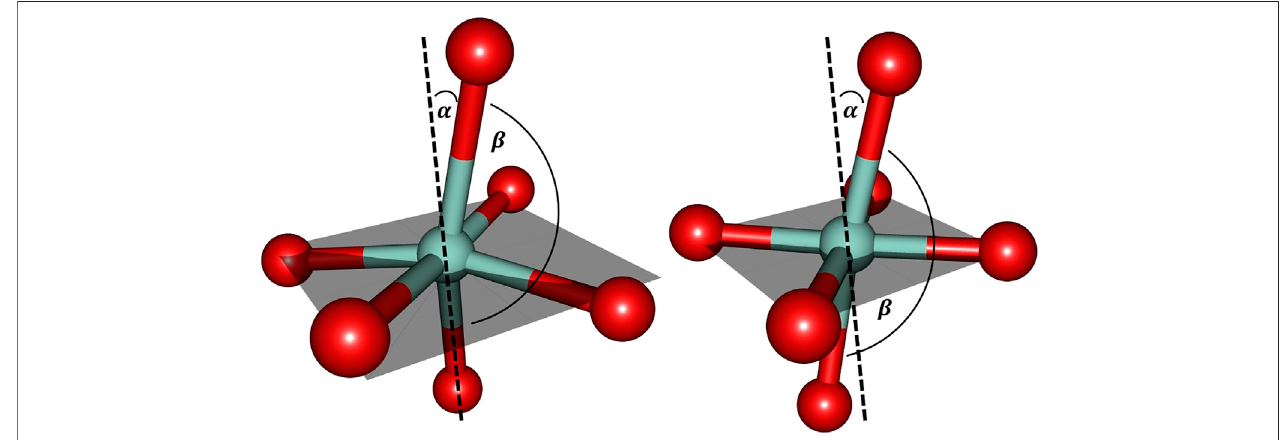
FIGURE 6 | Cobalt coordination sphere extracted from the crystal structure data by Emsley et al. (2000) (left) and the ligand sphere for the freely optimized [Co(OH 2 ) 6 ] 2+ complex (right) using the B3LYP/6-31G* level of theory. For the sake of clarity only the directly bound oxygen atoms are displayed. The gray shaded plane indicates the arrangement of equatorial ligands: in the optimized hexaaqua complex, the equatorial oxygen atoms essentially span a plane with minimal Co out-of-plane deviationwhiletheexperimentalsystemfeaturespronounceddeformations. α denotesthedeviationrelativetotheplanenormaland β O − Co − O depictstheaxialangle of the complex. The values for the angles are approximately given as: α (cid:2) 15 ° and β O − Co − O (cid:2) 165 ° (left) and α (cid:2) 10 ° and β O − Co − O (cid:2) 173 °